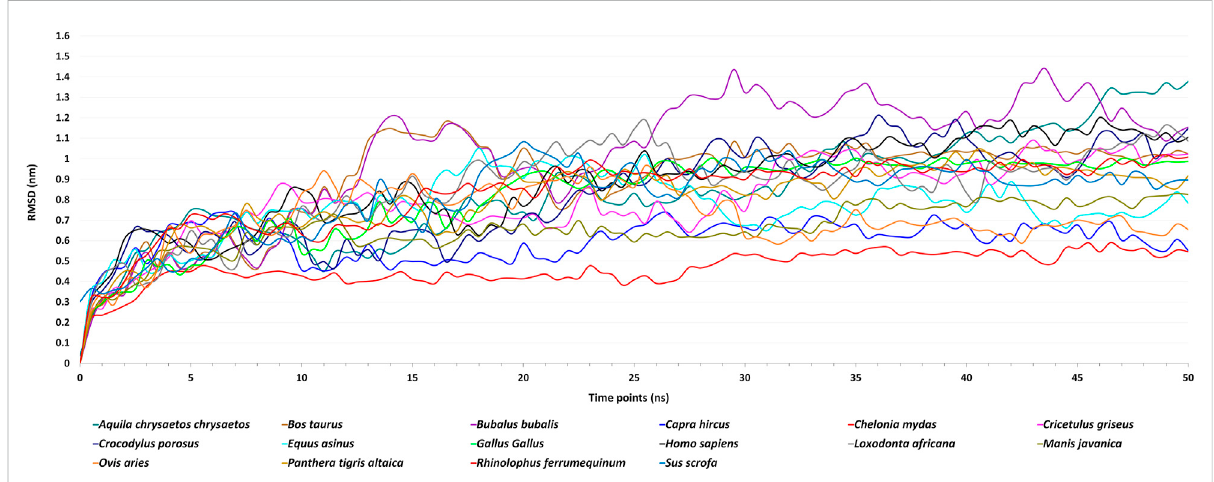
FIGURE 2 Figure showing Root Mean Square Deviation (RMSD) fl uctuations of the spike – ACE2 receptor complexes of 16 host organisms for the MD simulations of 50 ns.